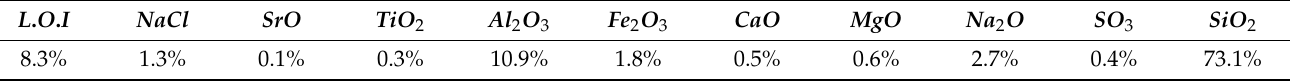
Table 3. Chemical analysis of zeolite.